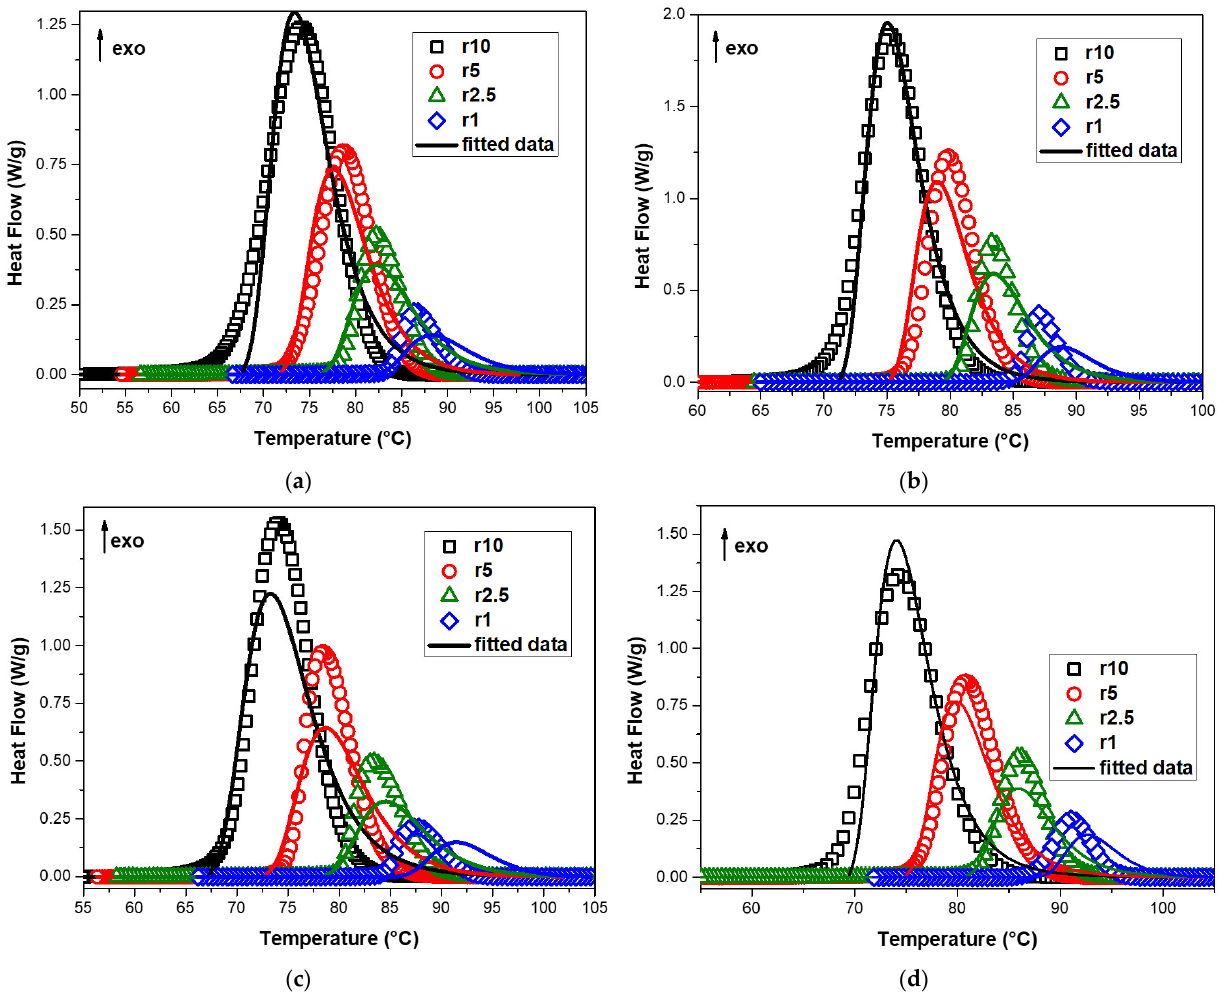
Figure 8. Heat fl ow curves of ( a ) neat PBSu, ( b ) PBSu/1% biochar, ( c ) PBSu/2.5% biochar, and ( d ) PBSu/5% biochar composites versus temperature and the corresponding fi tt ing of multivariate non- linear regression of the JMAEK model for single mechanism.